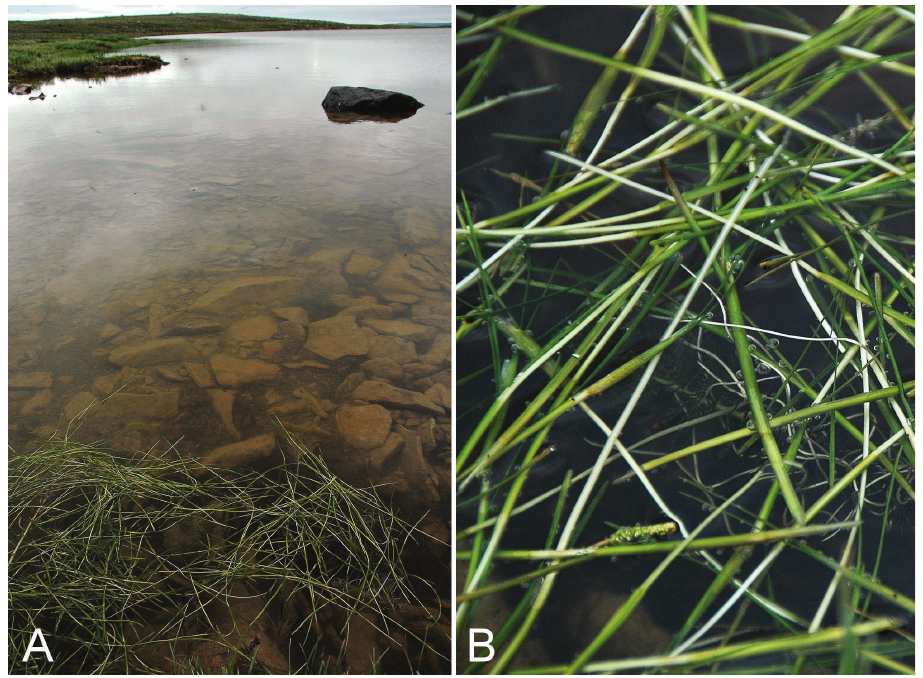
Figure 10. Stuckenia vaginata : A habitat B habit, Gillespie et al. 8048 . Photographs by R.D.